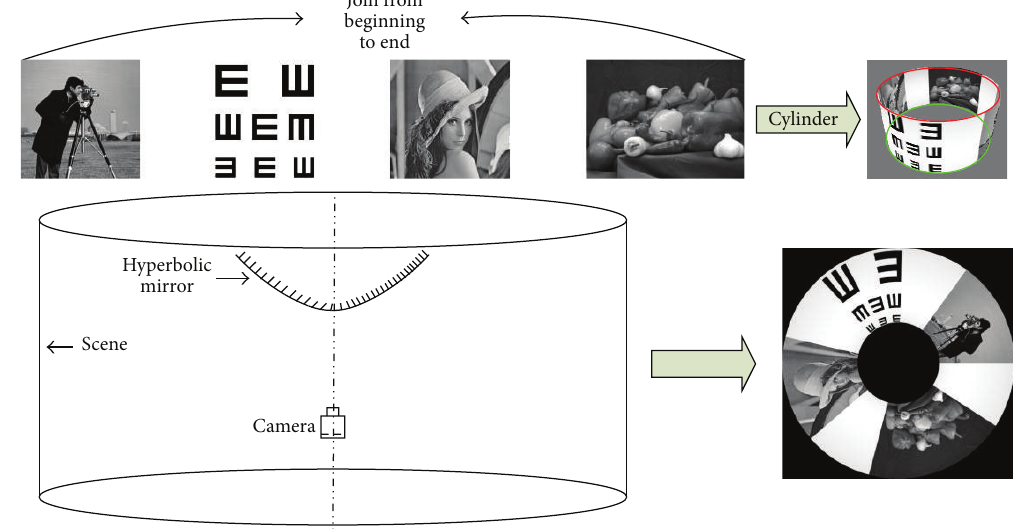
Figure 5: Simulation test image of catadioptric omnidirectional